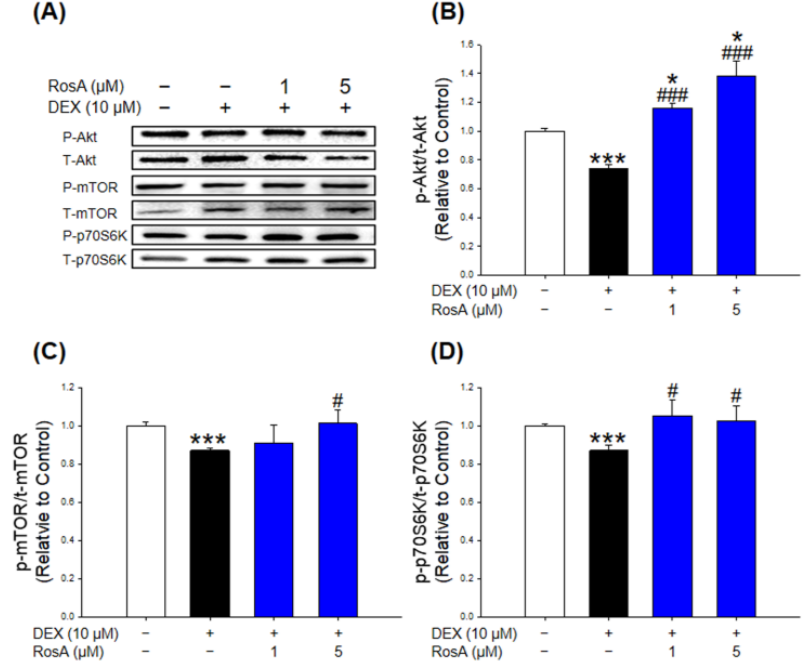
Figure 3. Effects of RosA on the Akt/mTOR/p70S6K pathway in DEX-mediated atrophy in C2C12 myotubes. ( A ) Western blot of p-AKT, AKT, p-mTOR, mTOR, p-p70S6K, p70S6K, and FoxO3a proteins in C2C12 myotubes treated with 10 µ M DEX in the presence or absence of RosA (1 and 5 µ M) for 24 h. ( B ) Quantitative analysis of the p-Akt/Akt. ( C ) Quantitative analysis of the p-mTOR/mTOR. ( D ) Quantitative analysis of the p-p70S6K/p70S6K. These results are presented as the means ± SD of three independent experiments: * p < 0.05, *** p < 0.001 vs. control; # p < 0.05, ### p < 0.001 vs. DEX. 2.4. Effects of RosA on Reactive Oxygen Species (ROS) Production, Superoxide Dismutase (SOD) Activity, and Apoptosis in DEX-Treated C2C12